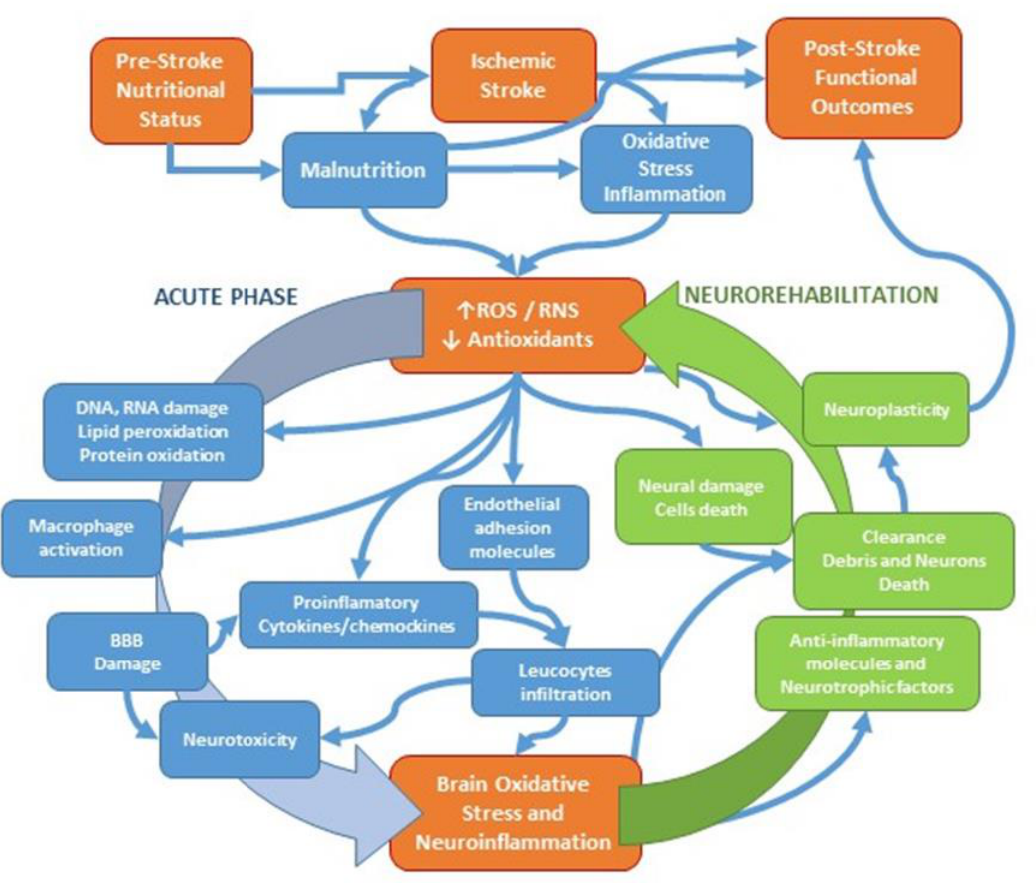
Figure 3. Schematic representation of stroke-associated oxidative stress and inflammation involve- ment in acute and rehabilitation phases. ROS, reactive oxygen species; RNS, reactive nitrogen species; BBB, blood – brain barrier; ↑ , increase; ↓ , decrease.